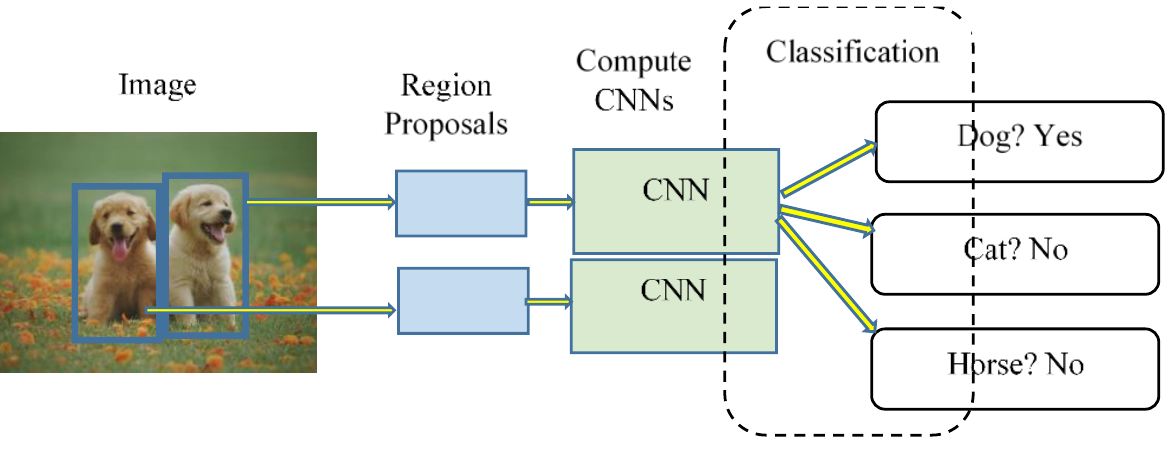
Figure 2. R-CNN architecture where CNNs are computed only for proposed regions.